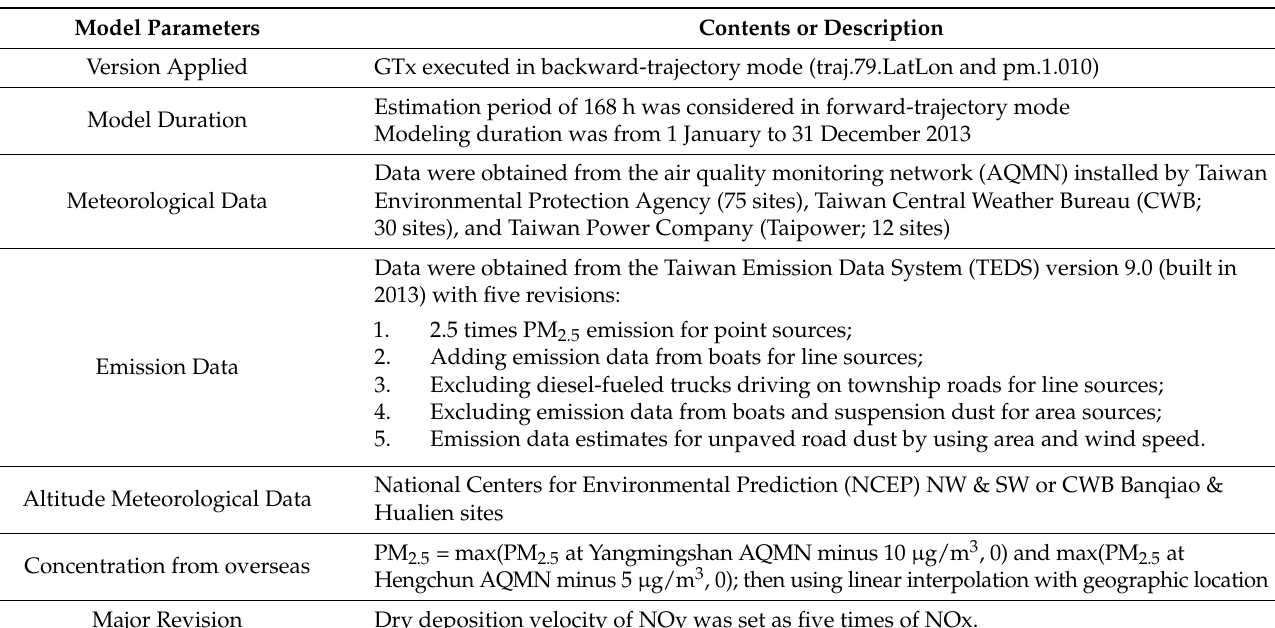
Table 2. Parameters used in the Gaussian trajectory transfer-coefficient (GTx)